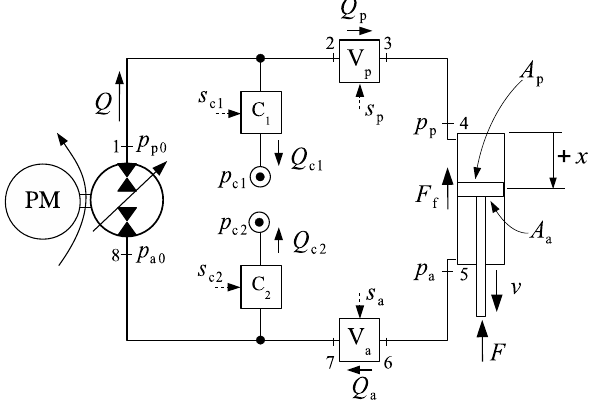
Figure 2. General representation of a typical valve-compensated single-rod hydrostatic actuator.